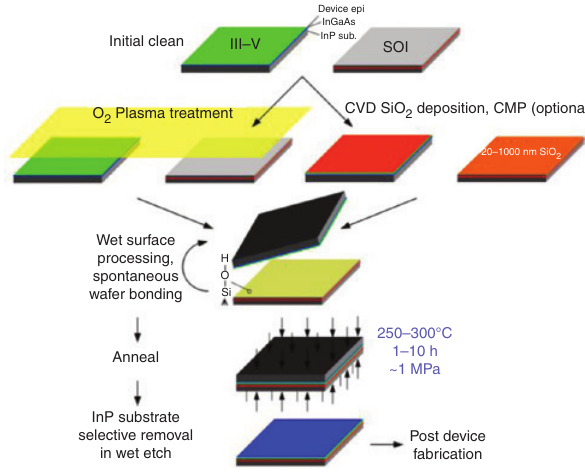
Figure 1: Schematic published by Liang et al. [2], comparing O plasma assisted and SiO covalent wafer bonding methods. Both 2 methods of manufacture provide an alternative to high-temperature bonding not conducive to III–V silicon substrate processing.